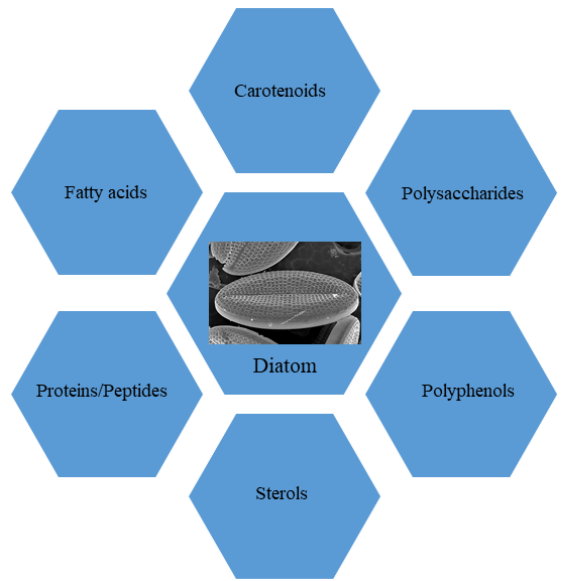
Figure 1. Bioactive molecules isolated from diatoms and functionally evaluated, as summarized in this review.